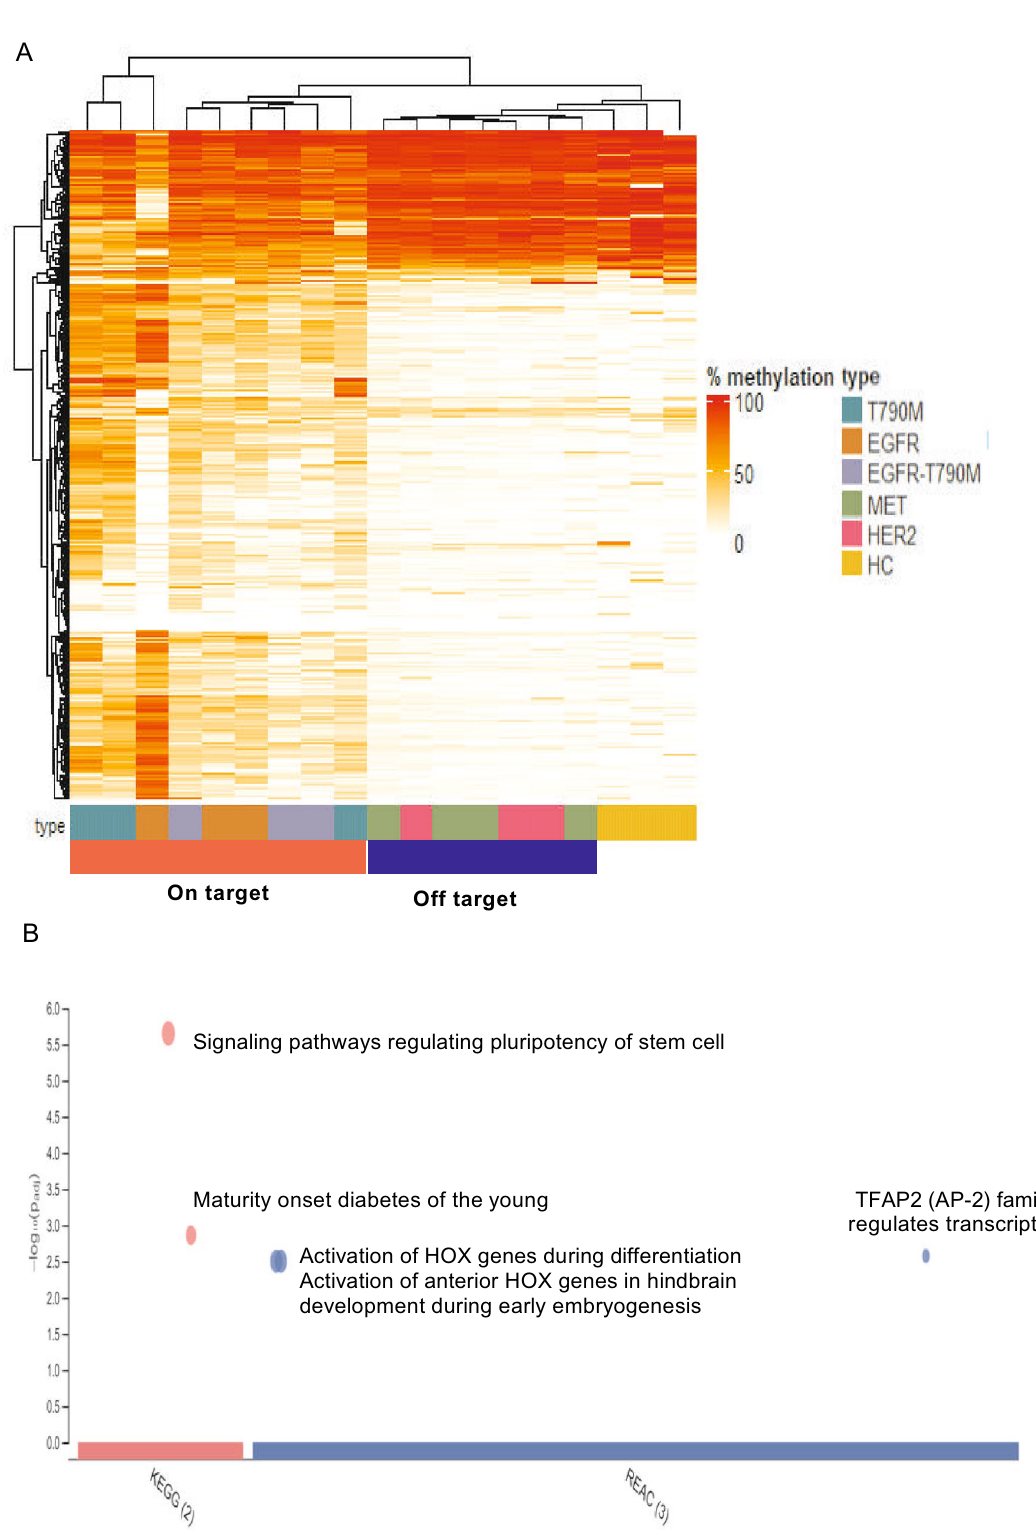
Figure 4. EGFR dependent resistance mechanisms displayed markedly high levels of hyper-methylation in the transcriptional regions of genes involved in regulation of differentiation. ( A ) Heat-map showed differentially methylated regions (DMRs) among 450 target regions mapped to regulatory regions of cancer related genes across samples within the on-target group (T790M, T790M-EGFR amplification and EGFR amplification) and off-target group (HER2 and MET amplification). Healthy subjects were used as a reference group to determine the basal levels of methylation at target regions. Heatmap visualization was analyzed with ComplexHeatmap package version 2.8.0 (https:// www. bioco nduct or. org/ packa ges/ relea se/ bioc/ html/ Compl exHea tmap. html). Hierarchical clustering was done using Euclidean distance. Red in the scale bar represents a high level of methylation. ( B ) KEGG and Reactome pathway enrichment analysis using g: Profiler (https:// biit. cs. ut. ee/ gprofi ler) for genes associated with 202 DMRs showing hyper-methylation in the on-target group compared to the off-target